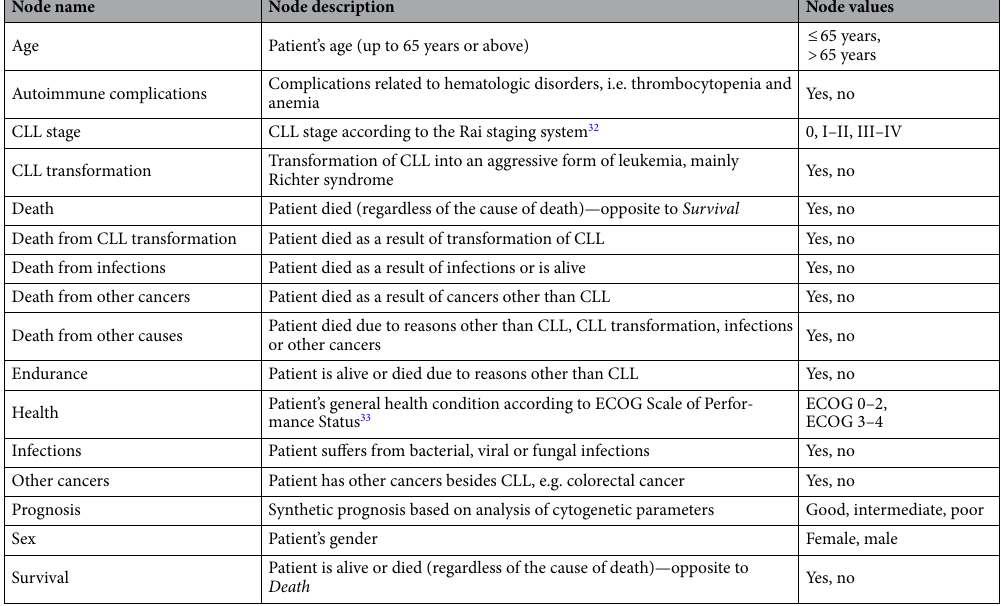
Table 1. Nodes of the health status network.